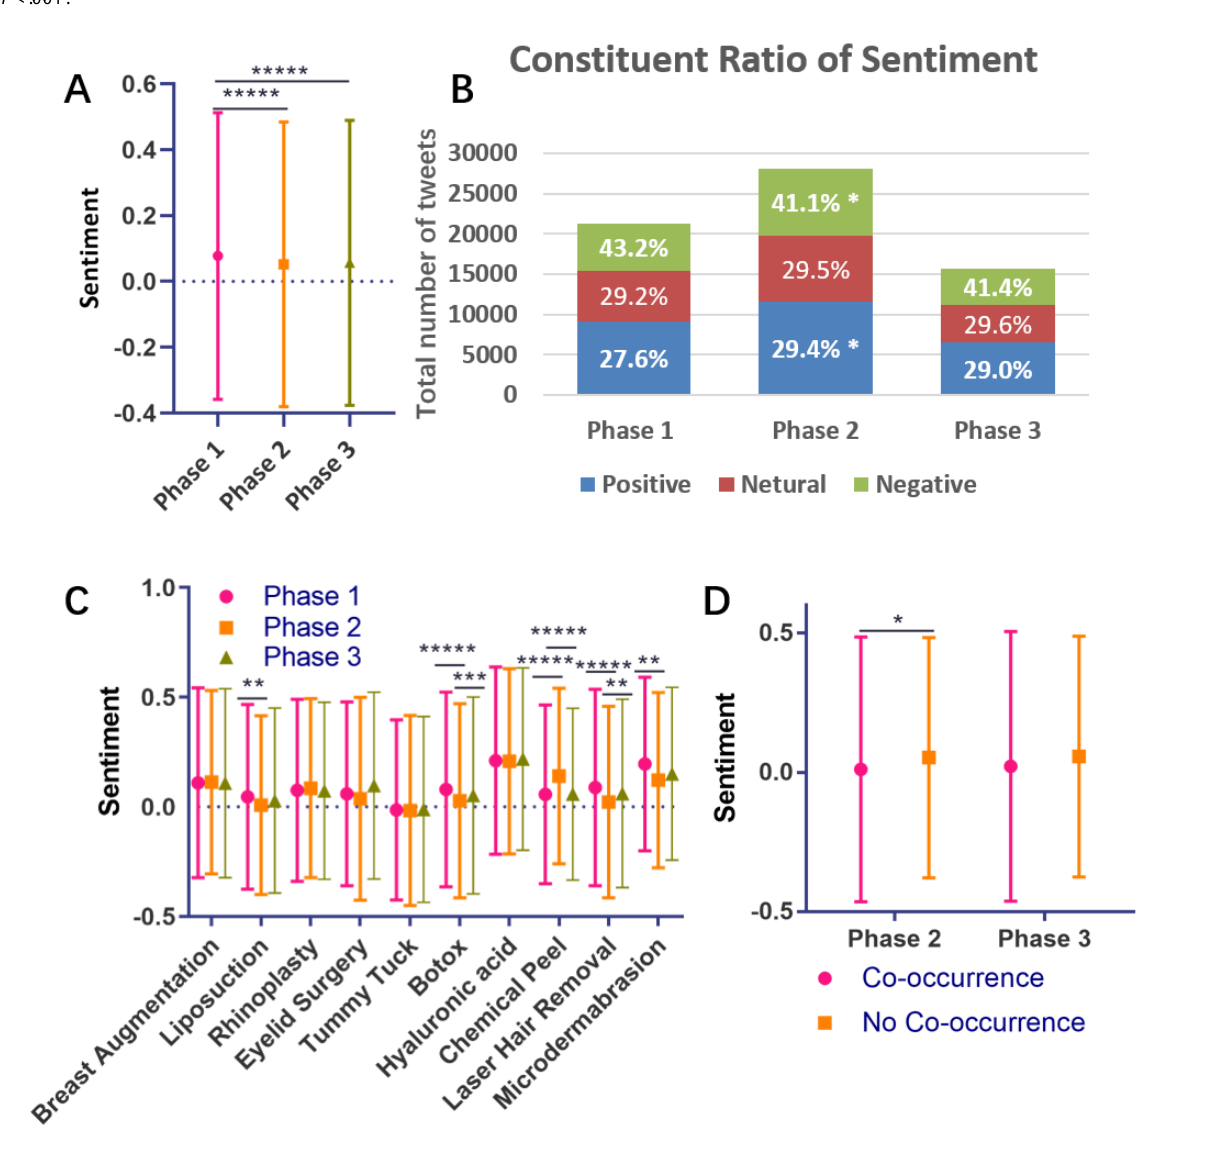
Figure 4. (A) Overall tweet sentiments in the three different phases. A negative number indicates negative sentiment, and a positive number indicates positive sentiment. (B) Total numbers and constituent ratios (labels in cells) of sentiments in different phases. (C) Sentiments for specific procedures. (D) Sentiments for tweets in which mentions of the procedures do or do not co-occur with mentions of COVID-19 in phases 2 and 3. * P <.05, ** P <.01, *** P